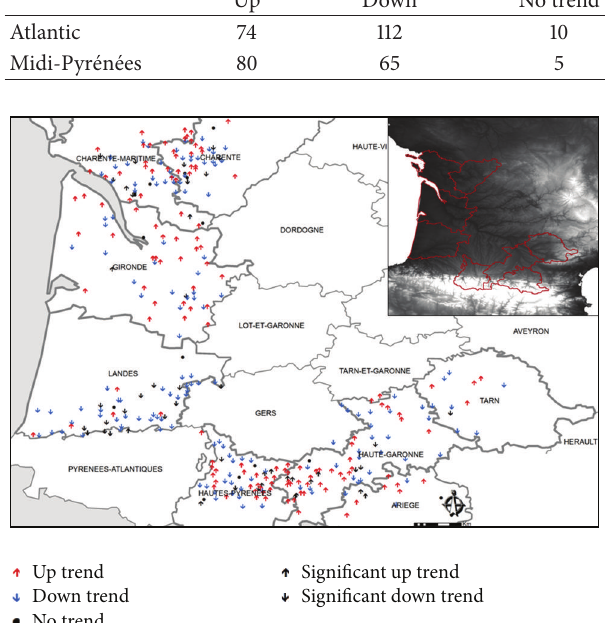
Figure 3: Geographical distribution of hailpads with upward, downward, and no trend from 1990 to 2010. The significant trends are shown in